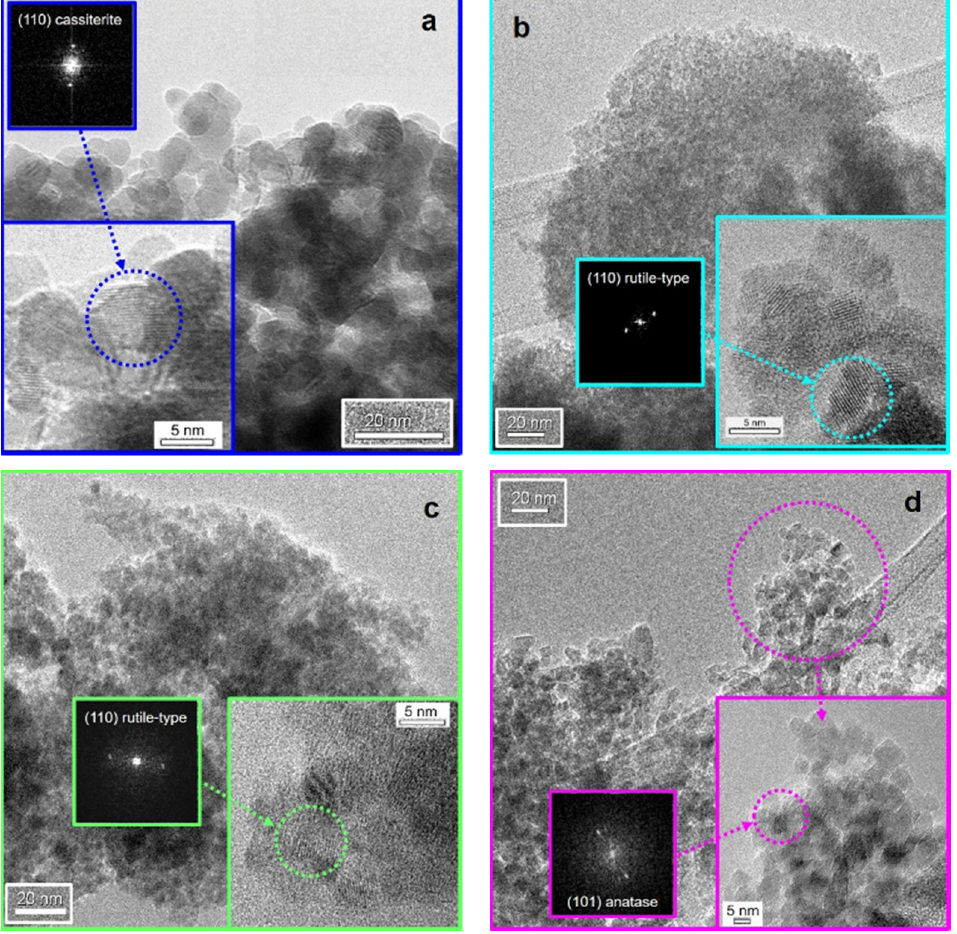
Figure 2. TEM images of ( a ) 32:1 SnO 2 /GO, ( b ) 32:1 Sn 0.55 Ti 0.45 O 2 /GO, ( c ) 32:1 Sn 0.44 Ti 0.56 O 2 /GO and ( d ) 32:1 TiO 2 /GO, as representative samples (insets: relative magnifications together with the relative Selected Area Electron Diffraction, SAED, patterns).